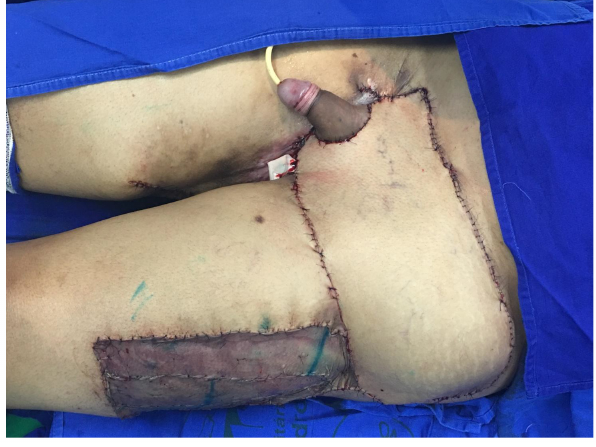
Figure 4. Aspect